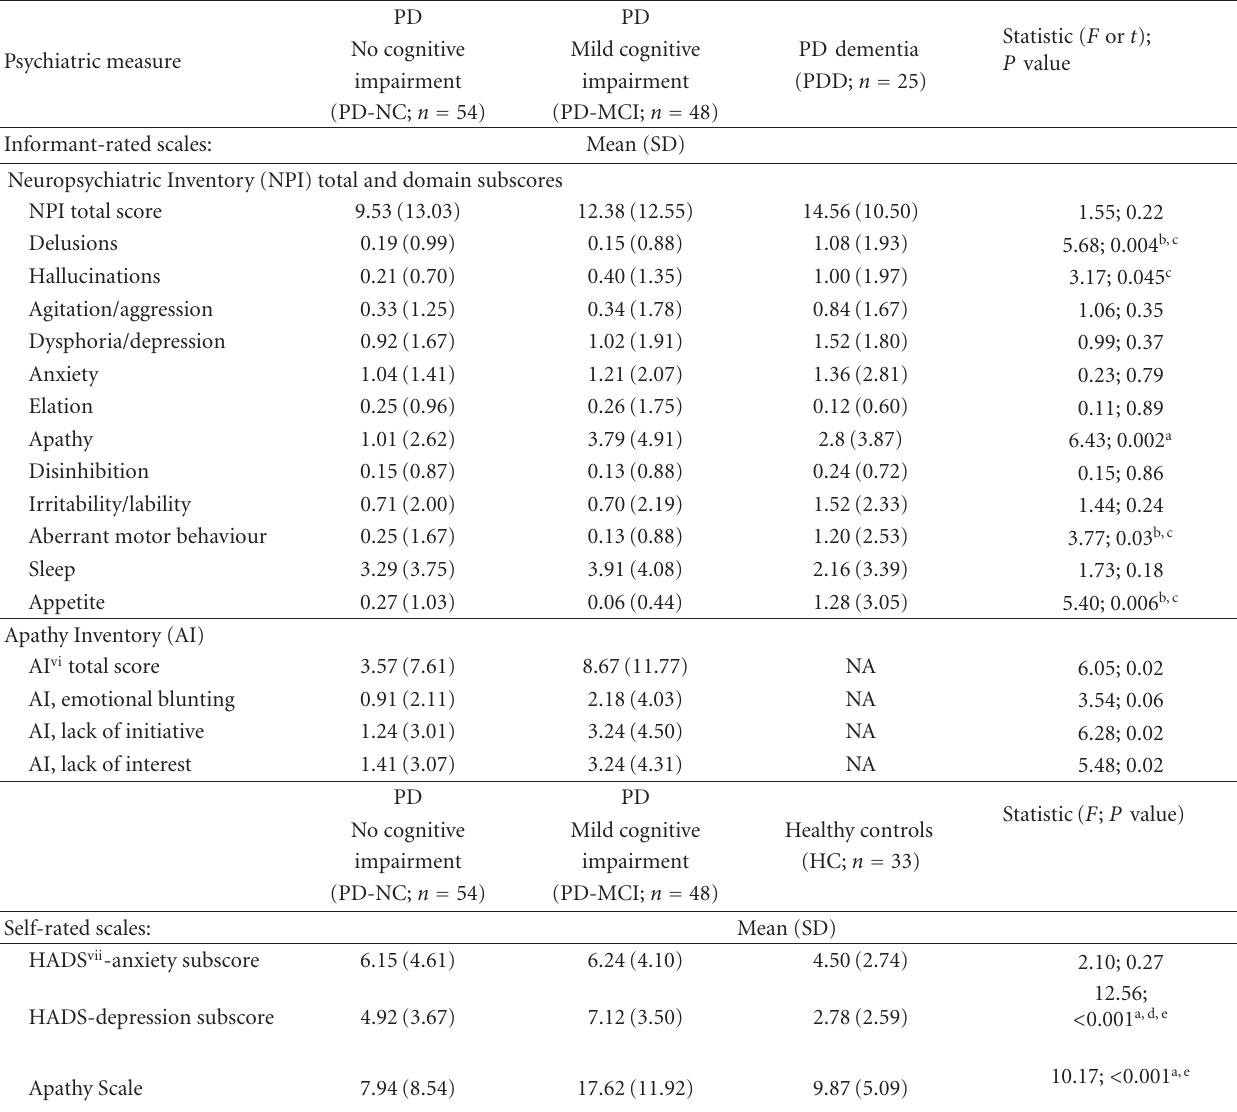
Table 4: Mean domain scores ( f requency × severity ) of the neuropsychiatric inventory items, apathy ratings, and self-rated depression and